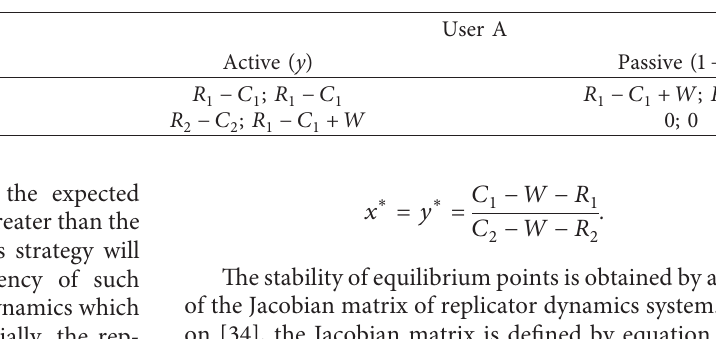
Table 4: Game matrix of user participation in co-creation